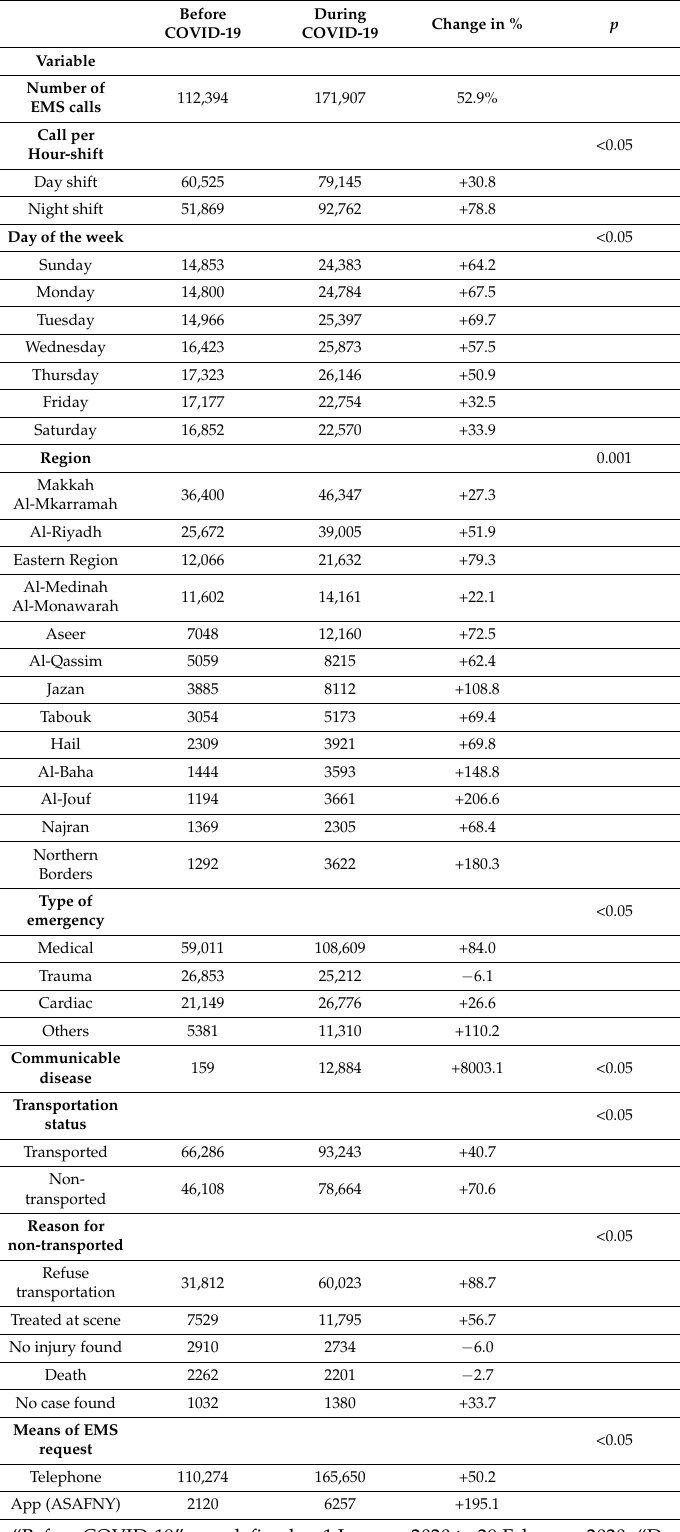
Table 2. Description of SRCS emergency calls (n = 284,301) in Saudi Arabia before and during the